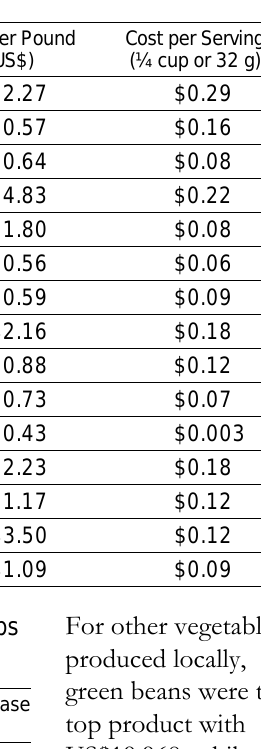
Table 1. Top 15 Local Food Products